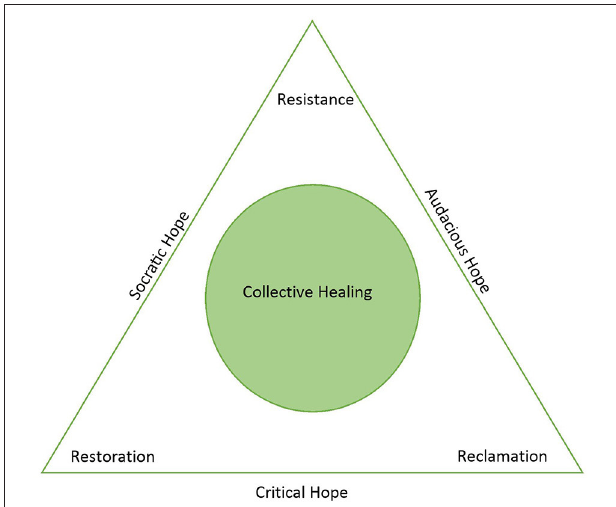
FIGURE 1 | Radical healing justice framework in schools.